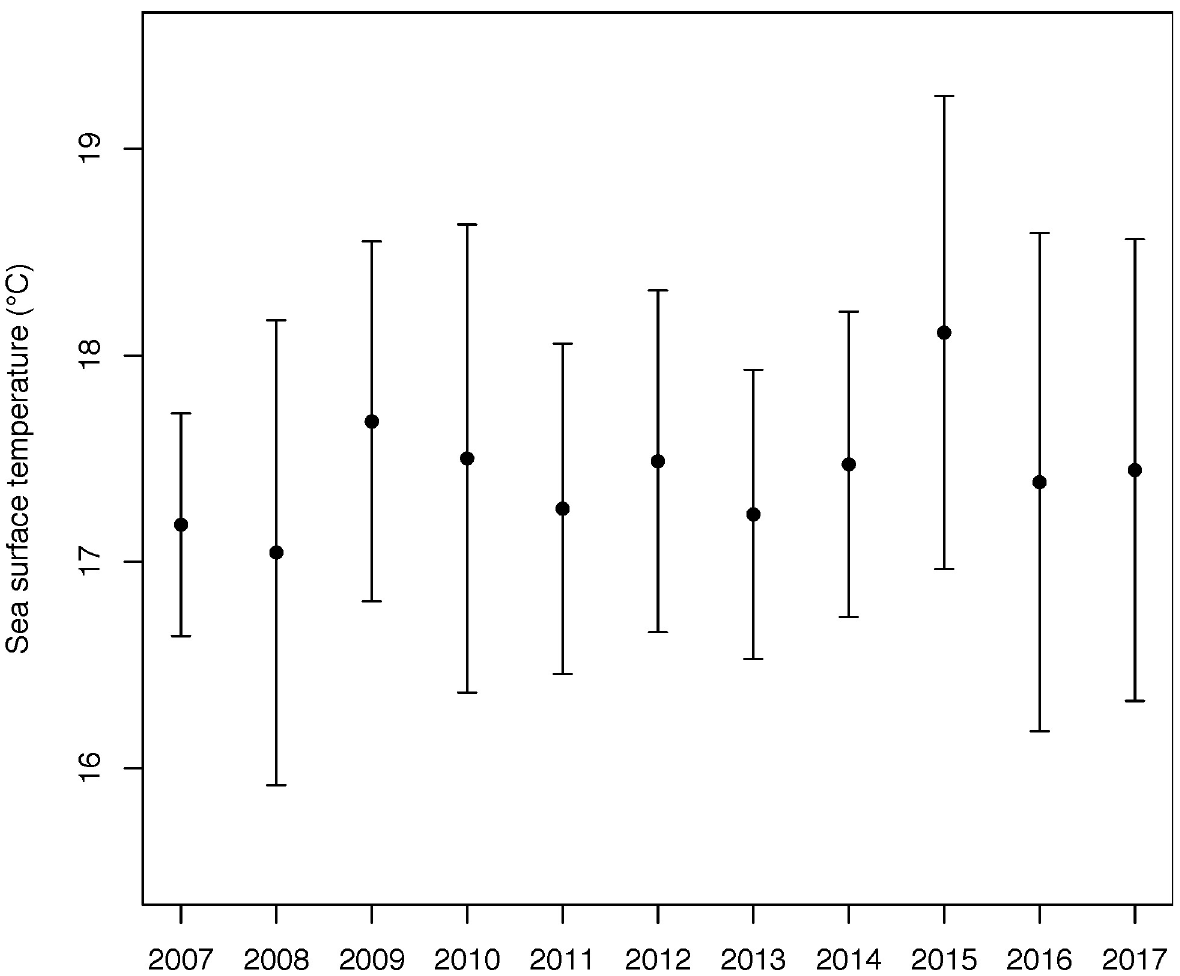
Fig 8. October sea surface temperature (˚C; average with error bars showing SD) across 2008–2017 within the Malgas Cape gannet at-sea core home-range (90% kernel distribution), as determined via GPS-tracking of birds provisioning small chicks.